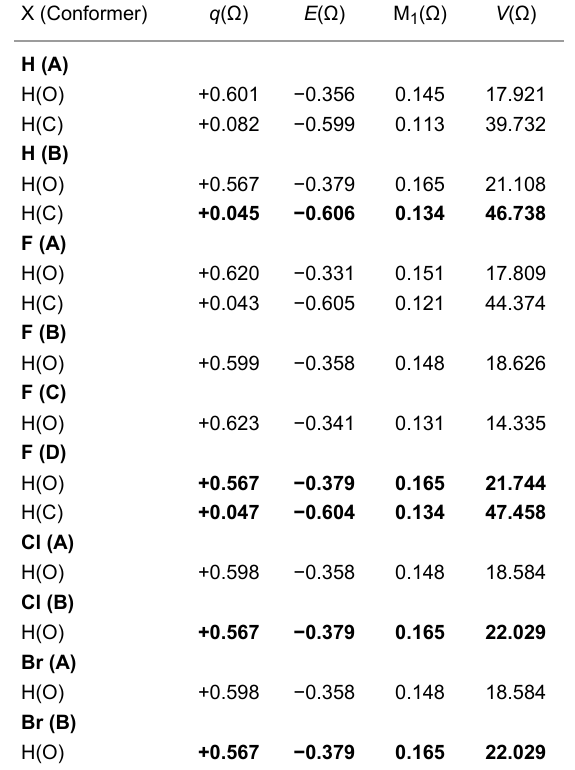
Table 3: QTAIM parameters (a.u.) for the hydrogen involved in HB and the halogens involved in electrostatic halogen